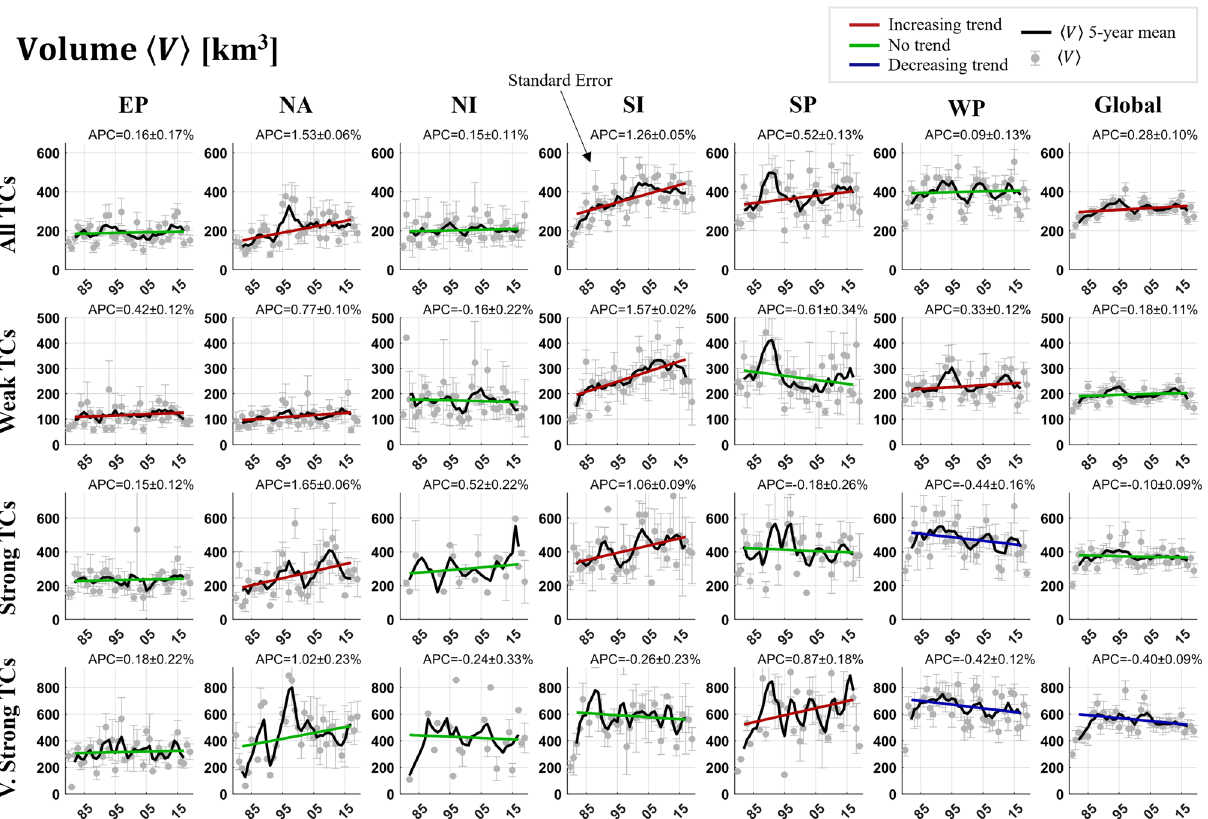
Figure 2. Trend analysis of mean TC precipitation volume totals ( (cid:31) V (cid:30) ), separated by intensity and basin classifications. Gray values with standard error uncertainty bounds indicate annual average values while black lines display five-year average timeseries data. Colored lines indicate trend of the fitted linear model and the colors red, blue, and green indicate a statistically significant increasing, decreasing, and insignificant trend at α = 0.05, respectively. Numbers on the top right of each subfigure are the annual percent change (APC) of the trend line and the standard error. Time-axis units are the last two digits of the calendar year, from 1980 to